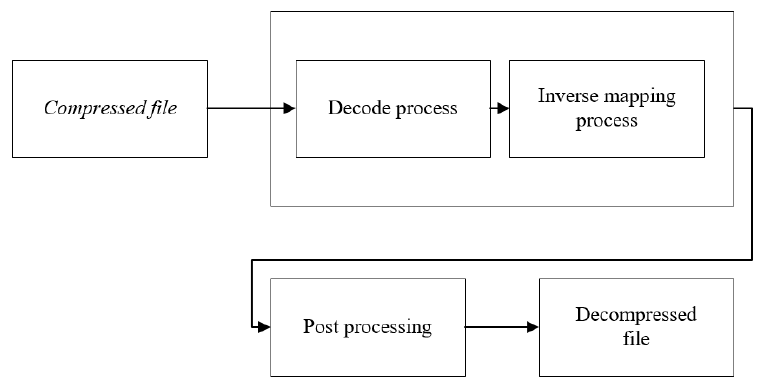
Figure 7. Decompression stages.